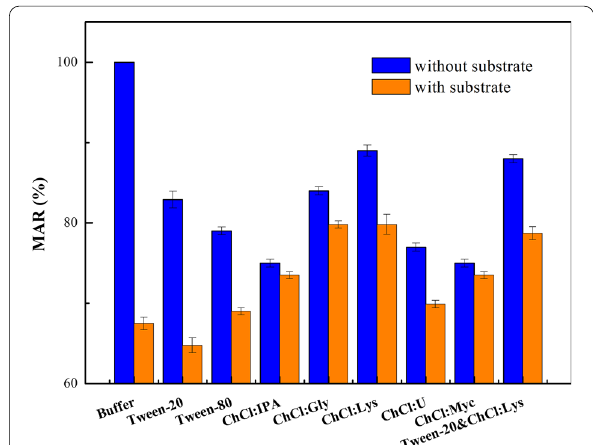
Fig. 6 MAR of recombinant E. coli cells in different reaction media. Reaction conditions: 200 mM of 3’-(trifluoromethyl)acetophenone, 17.2 g (DCW)/L recombinant E. coli cells, 0.6% (w/v) surfactant, 4% (w/v) NADES, PBS buffer (pH 7.0), 3 ℃ , 200 rpm